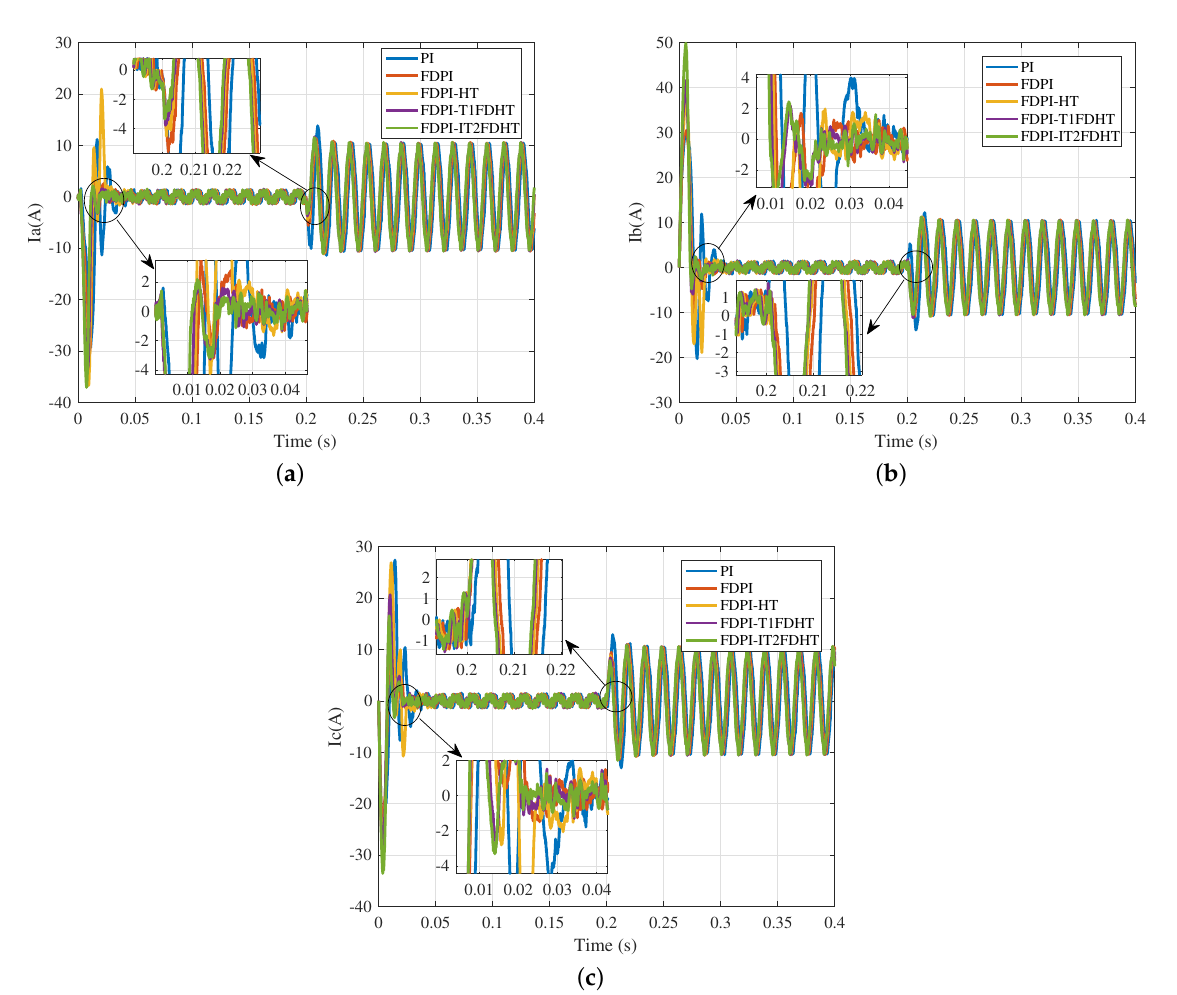
Figure 18. Current variation of Ia, Ib and Ic. ( a ) Ia; ( b ) Ib; ( c )